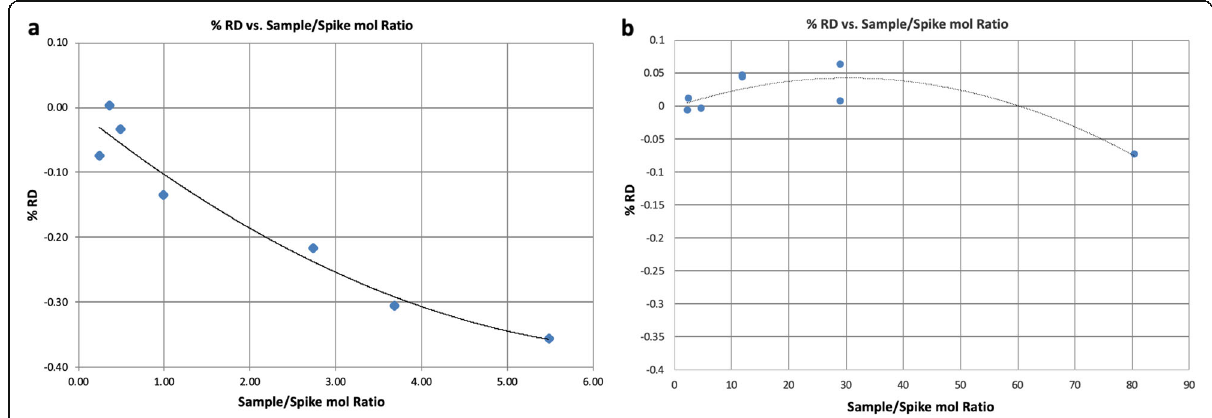
Fig. 3 Comparison in RD% vs. sample/spike mol ratios of between a previous data of Hasozbek et al. (2013) and b this